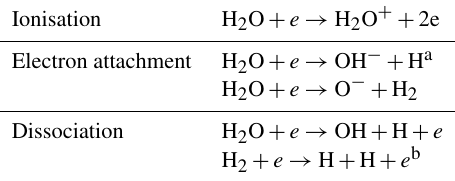
Table 4. Electric-field-driven processes additionally included com- pared to the model of Winkler and Notholt (2014). The reaction rate coefficients in air depending on the reduced electric field strength were calculated with the Boltzmann solver BOLSIG+ (Hagelaar and Pitchford, 2005) using cross-section data for H 2 O (Itikawa and Mason, 2005) and for H 2 (Yoon et al.,